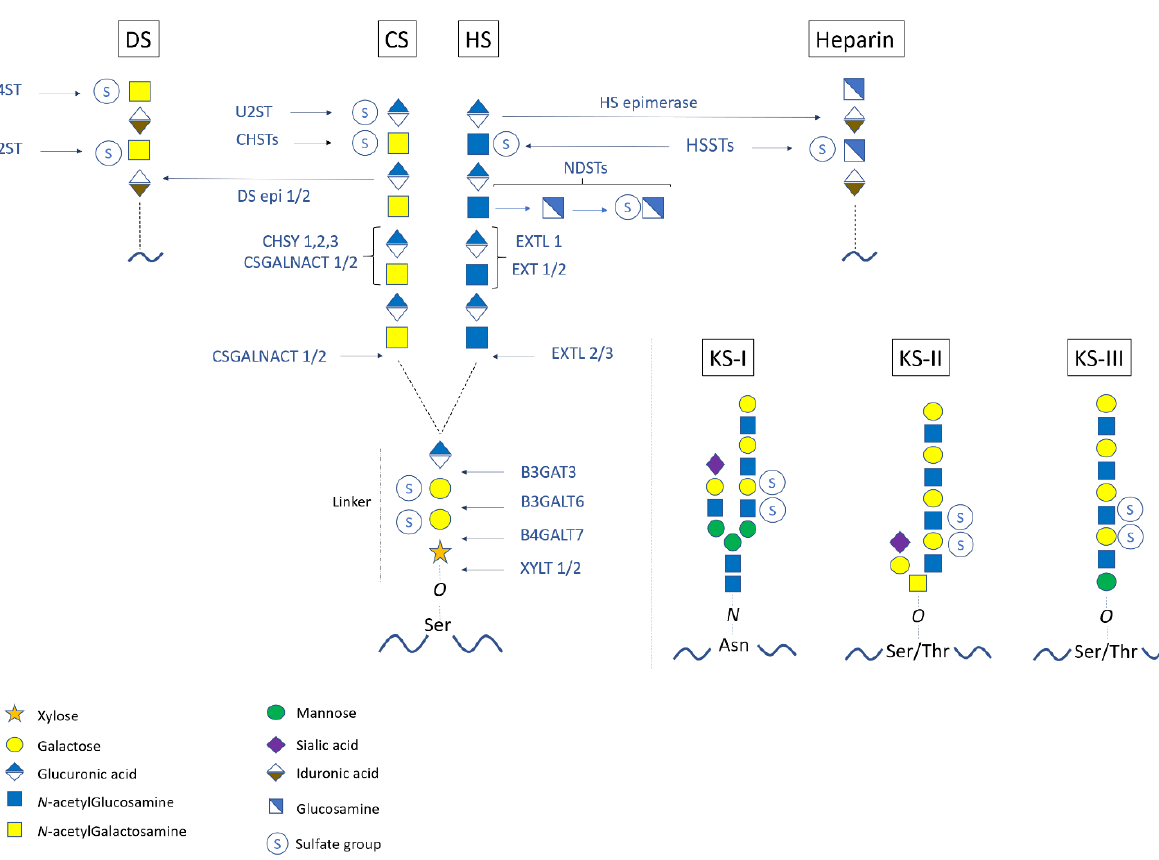
Figure 1. Biosynthesis and modifications of proteoglycans. Upon the core protein-linked tetrasaccharide linkage region (i.e., GlcA – Gal – Gal – Xyl), GAG chain polymerization starts with the transfer of a first amino sugar (i.e., GalNAc for CS and GlcNAc for HS) and continues with the addition of repetitive [GlcA – GalNAc] for CS and [GlcA – GlcNAc] for HS. Epimerization from CS to DS (i.e., [IdoA – GalNAc] backbone) and from HS to heparin (i.e., [IdoA – GlcNAc] backbone) could occur. The GAG chains are also modified by sulfate groups. Each pathway involves specific glycosyltransferases, sulfotransferases, and epimerases. For KS GAG chain elongation, there are three types of initiations leading to KS-I, KS-II, and KS-III GAG chains, which are composed of a polylactosamine backbone [GlcNAc – Gal]. Enzyme abbreviations: XYLT: Xylosyltransferase; B4GALT7: β -4- galcatosyltransferase7; B3GALT6: β -3- galactosyltransferase6; B3GAT3: β -3-glucuronyl-